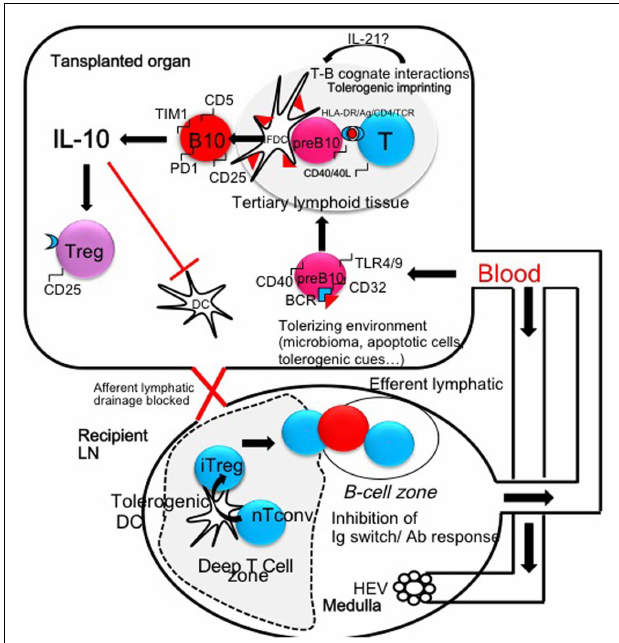
FIGURE 1 |The microenvironment and/or the microbiome (helminthes, parasites, bacterias) can shift B-cells that recognize microbial antigen in the spleen or in the transplanted organ toward regulatory B-cells (pre B10) .These cells may be generated in the spleen and colonize the transplanted organ. In turn activated B-cells may present donor MHC peptides toT-cells and undergo cognateT-B interactions in tertiary lymphoid organs through CD40/CD40L, HLA-DR/TCR, and HLA-DR/CD4 interactions. These interactions generate an amplification loop: in the presence of IL-21 secreted byT-cells, B-cells become IL-10-secreting cells, express CD5, TIM1, and PD-1 molecules. In turn, IL-10 inhibits antigen presentation by professional APC (Dendritic cells) and amplifies the production ofTreg cells, themselves a potent source of local IL-10.Treg cells migrate to peripheral lymph node through the blood stream and concur to the inhibition ofTh1 andTh2 polarization. In additionTreg migrate to the B-cell follicles where they inhibit Antibody secretion and Immunoglobulin isotype